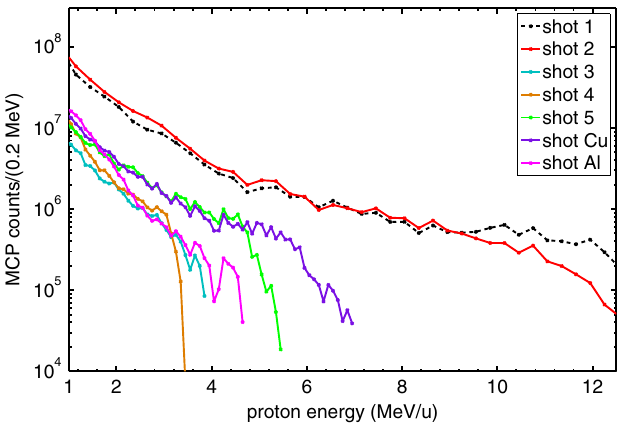
FIG. 3. Comparison of all proton spectra discussed in the text.